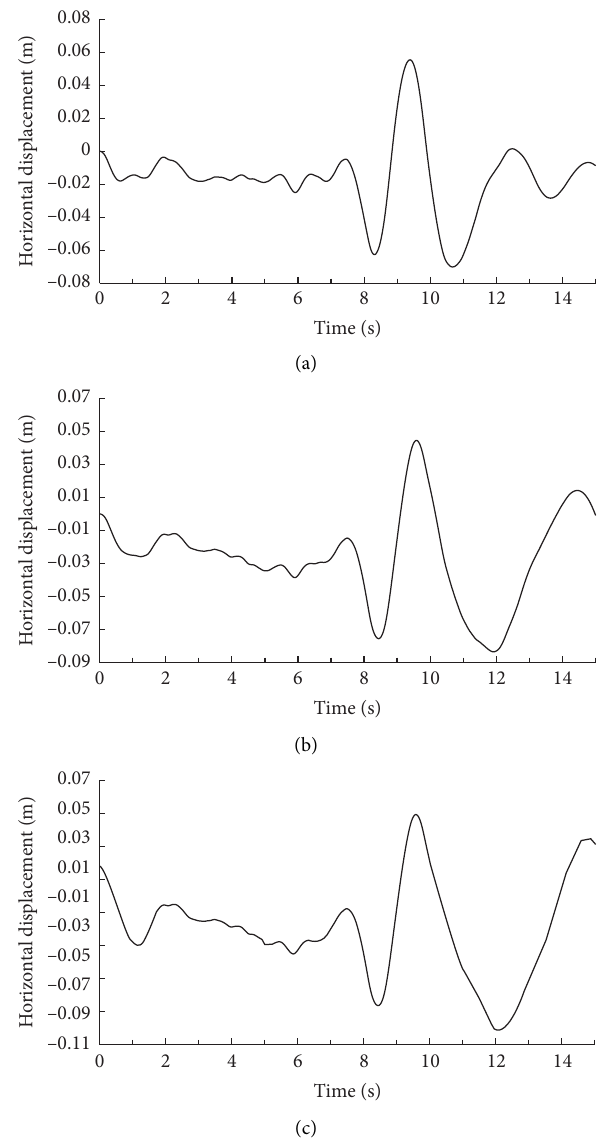
Figure 5: Horizontal displacement-time history curves for (a) the 30 m layer at node 818, (b) the 60m layer at node 596, and (c) the 80m layer at node